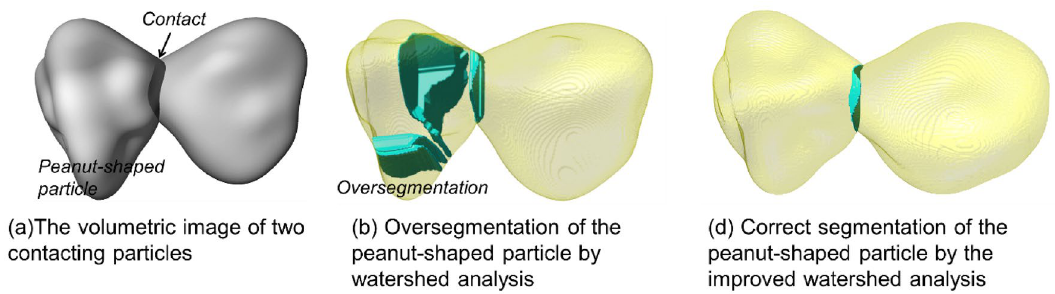
Fig. 2 Oversegmentation by watershed analysis and correct segmentation by improved watershed analysis